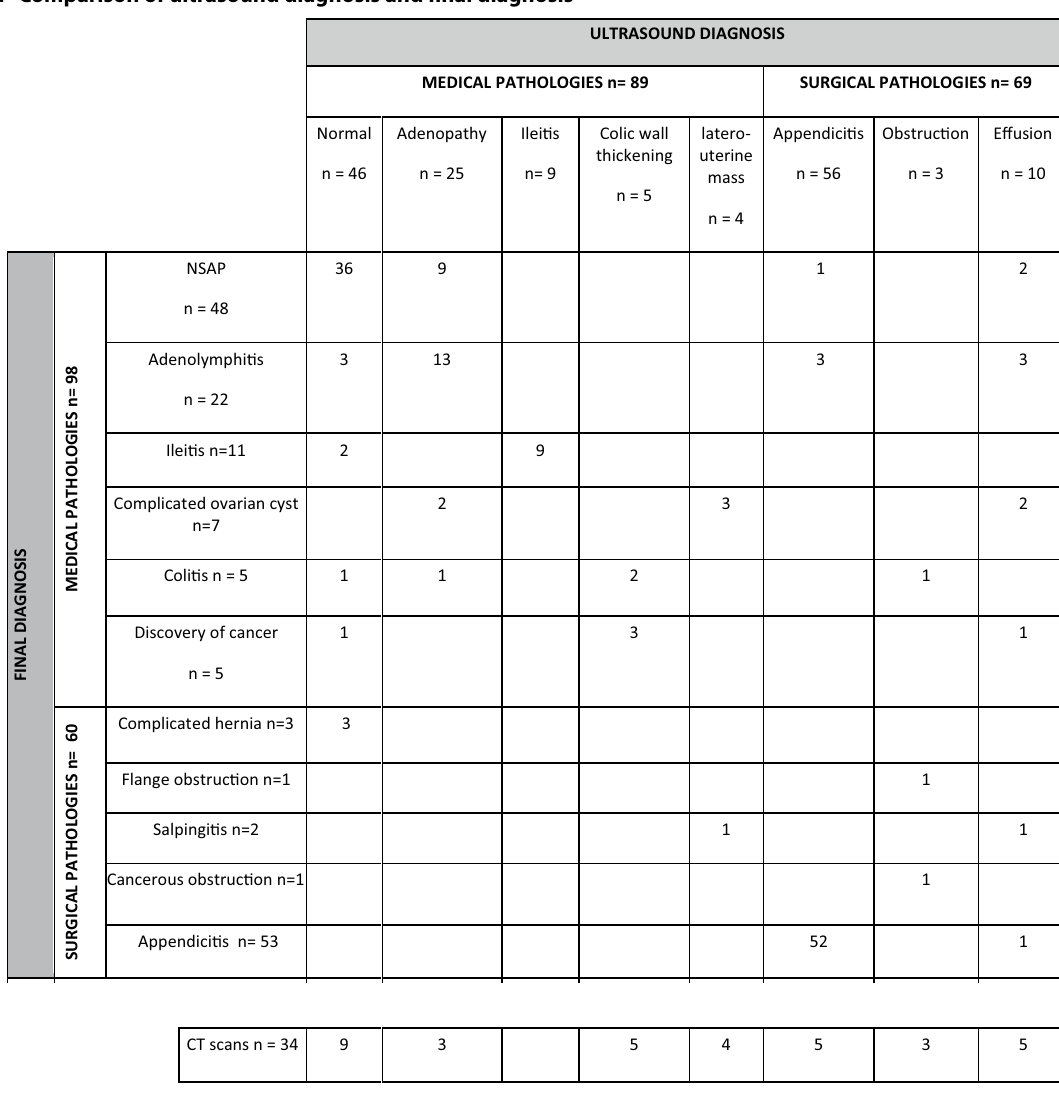
Table 1 Comparison of ultrasound diagnosis and final diagnosis